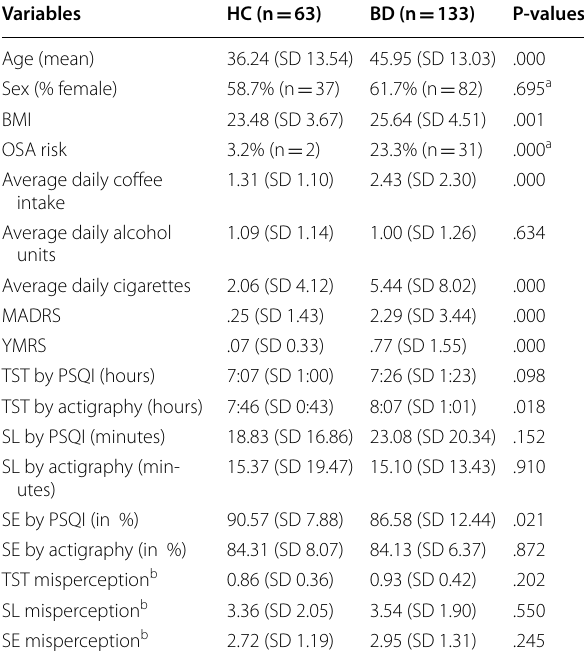
Table 1 Univariable comparisons between individuals with BD and HC for demographics, clinical and sleep